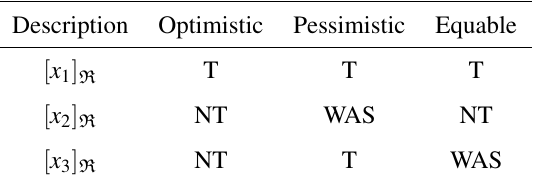
Table 3. A comparative analysis on different risk bias